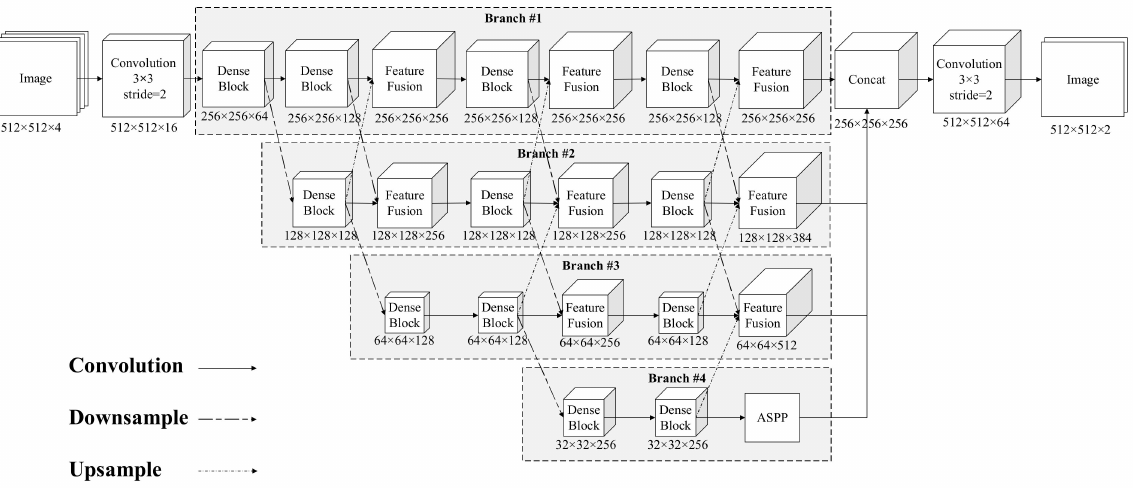
Figure 2. Network structure.